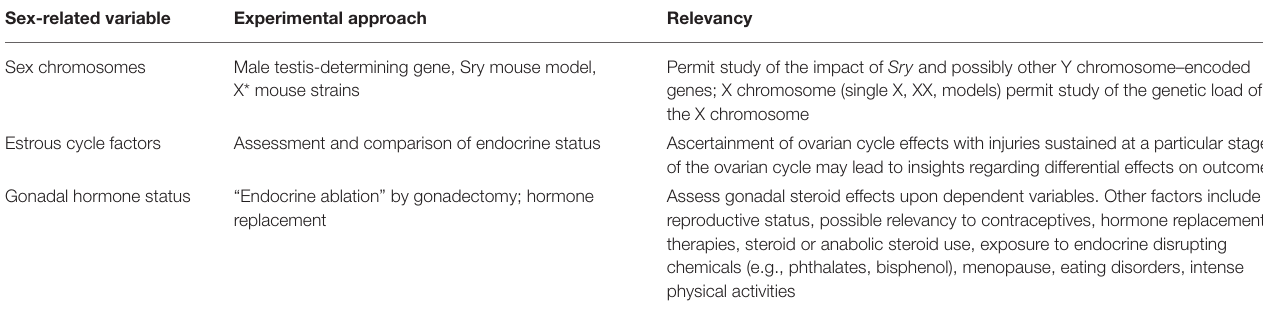
TABLE 1 | Approaches to sex as a biological variable in preclinical blast